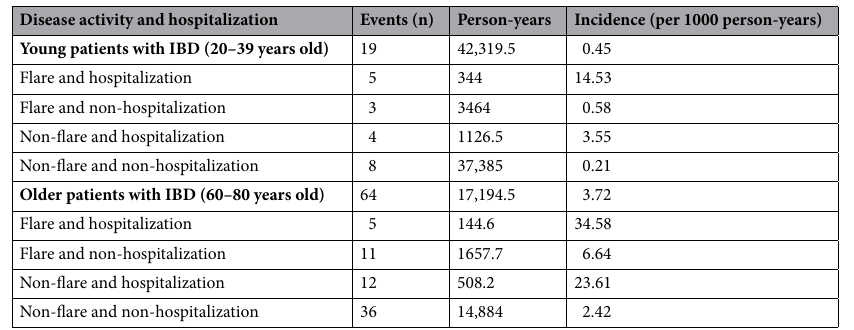
Table 6. Incidence of venous thromboembolism by disease activity and hospitalization according to age groups (young vs. old).